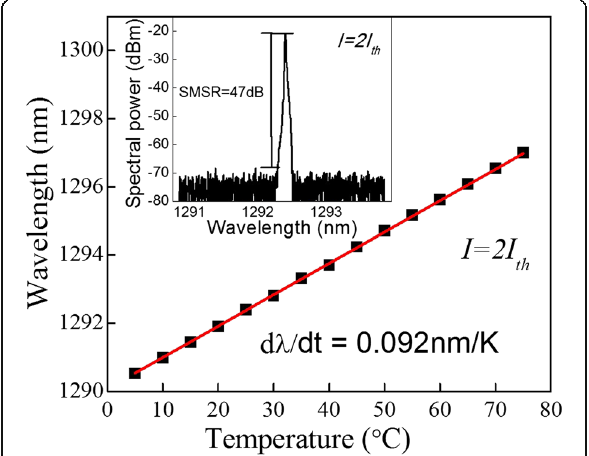
Fig. 3 Temperature dependence of emission wavelength. Inset: emission spectrum of the p-doped LC-DFB laser measured at 2 I